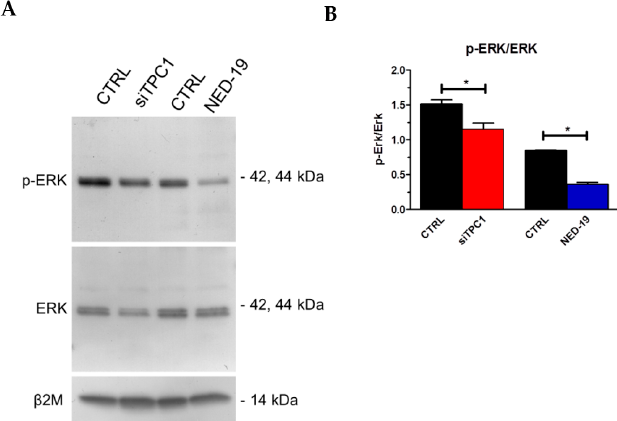
Figure 9. TPC1 stimulates extracellular-signal related kinases (ERK) phosphorylation in mCRC cells. p-ERK and ERK (Aa) bands in mCRC silenced for TPC1 or treated with NED-19 (100 µM, 30 min). Blots representative of four were shown. Lanes were loaded with 30 µg of proteins, probed with affinity purified antibodies and processed as described in Materials and Methods. The same blots were stripped and re-probed with anti- β -2-microglobulin ( β 2M) antibody, as housekeeping. Major bands of the expected molecular weights were shown ( A ). Bands were acquired, the densitometric analysis of the bands was performed by Total Lab V 1.11 computer program (Amersham Biosciences Europe, Italy) and the results were normalized to non-phosphorylated ERK ( B ). * p < 0.05 versus the respective control (Student’s t test). The asterisk indicates p < 0.05.